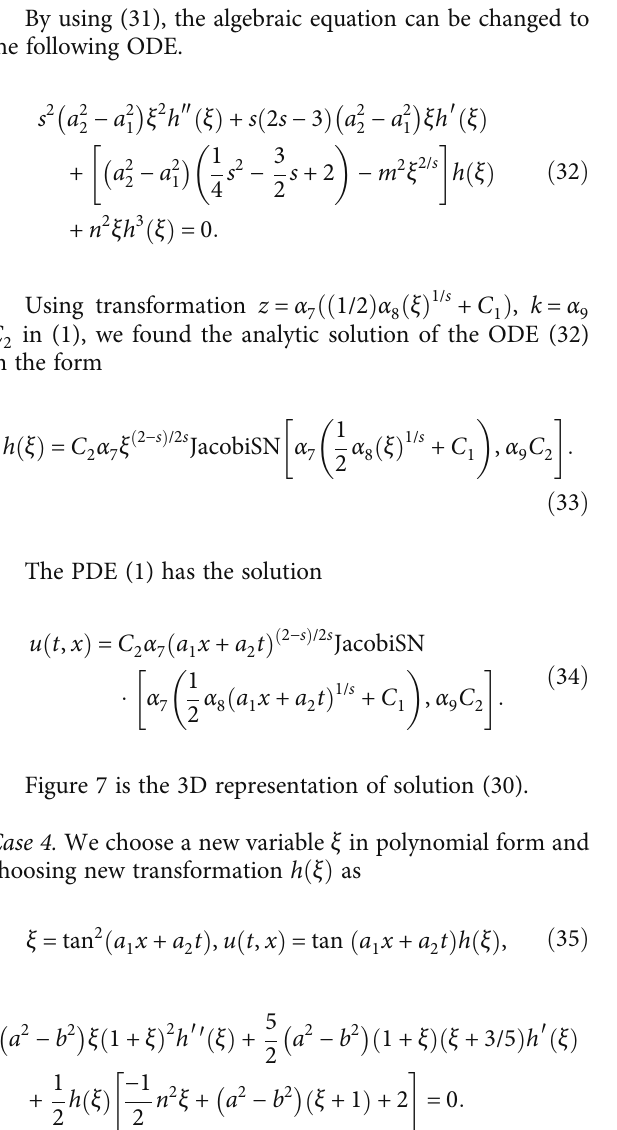
ffiffiffiffiffiffiffiffiffiffiffiffiffiffiffi p − n 2 + 8